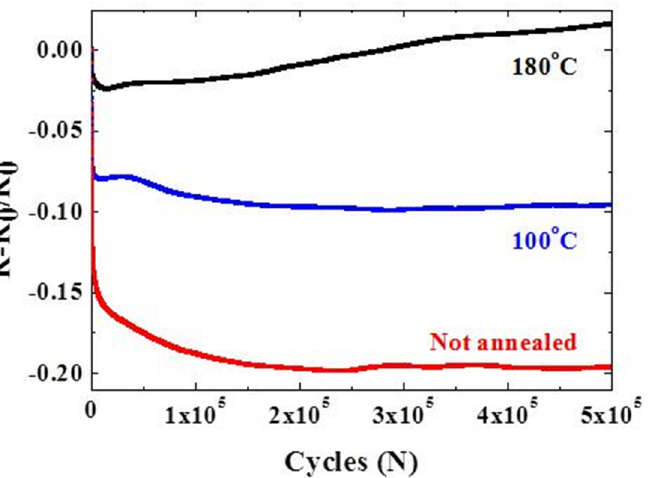
Figure 6. Cyclic bending test results of un-annealed silver nanowire networks. Reproduced with permission from ref. [28]. Copyright 2014, Wiley.